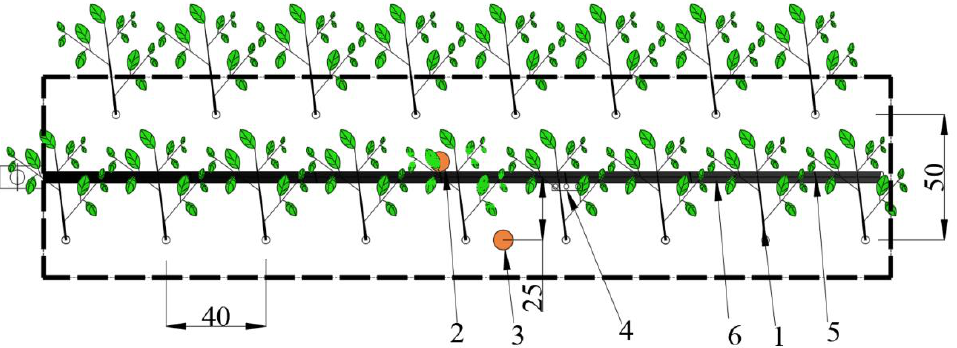
Figure 2. Schematic diagram of capillary and TRIME tube arrangement (unit: cm). Note: 1—tomato; 2—monitoring point, it was arranged at the single micropore group; 3—monitoring point, it was arranged at distance of micro-sprinkler hose 25 cm between the two single micropore groups; 4—geothermometer; 5—single micropore group; and 6—micro-sprinkler hose.